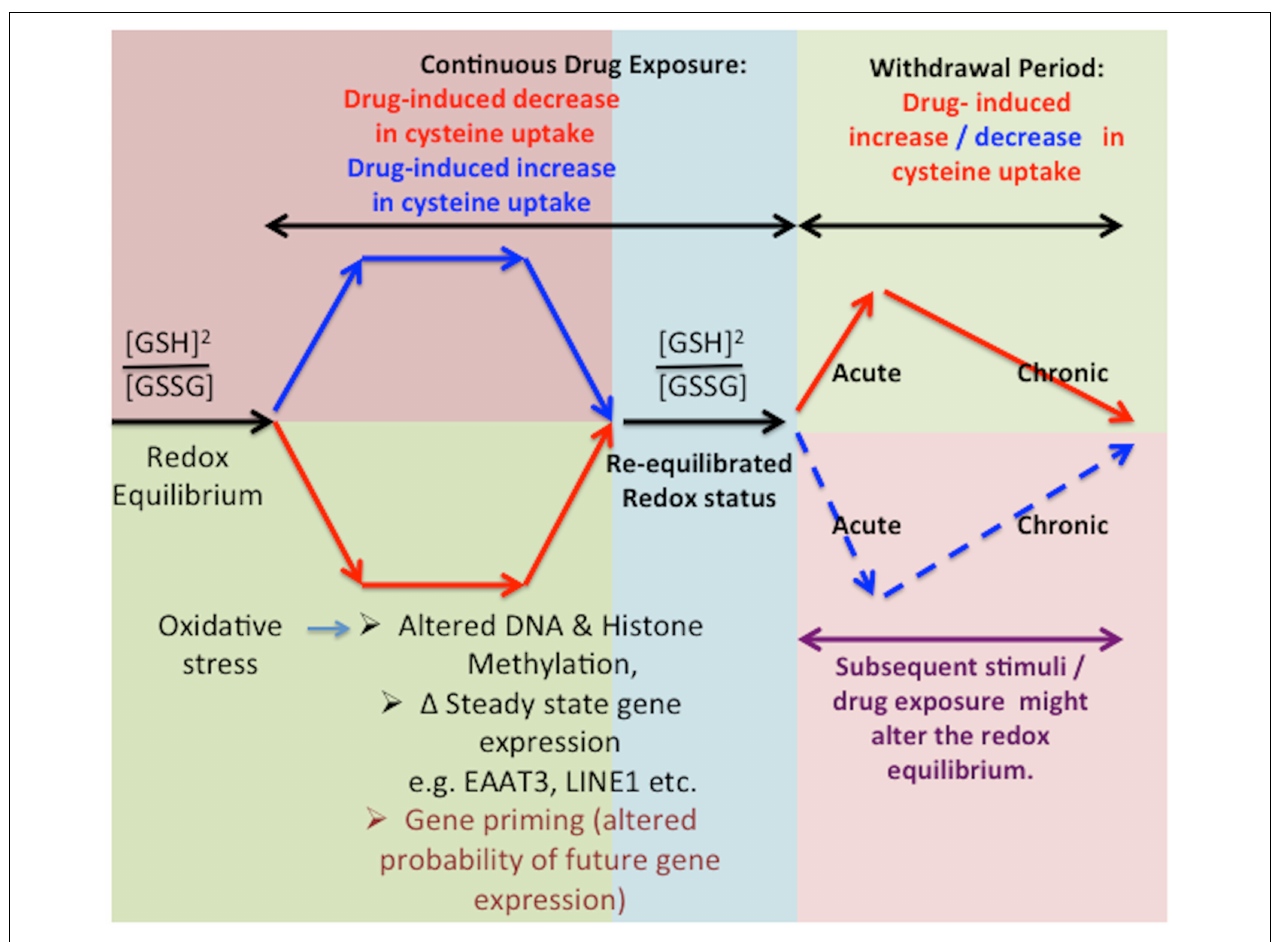
FIGURE 3 | Effect of in vitro washout on redox equilibrium. Inhibition of cysteine uptake can alter cellular redox potential, resulting in adaptive changes in gene expression via epigenetic effects, which restore the redox equilibrium. However, in the absence of opioids during the washout